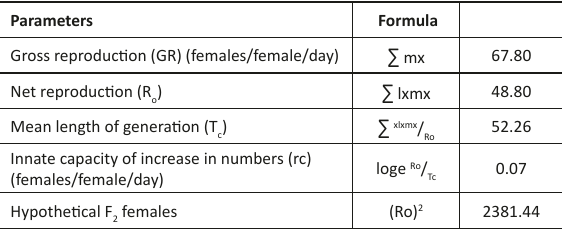
Table 3. Life table parameters of Cydnocoris gilvus on G. mellonella under laboratory